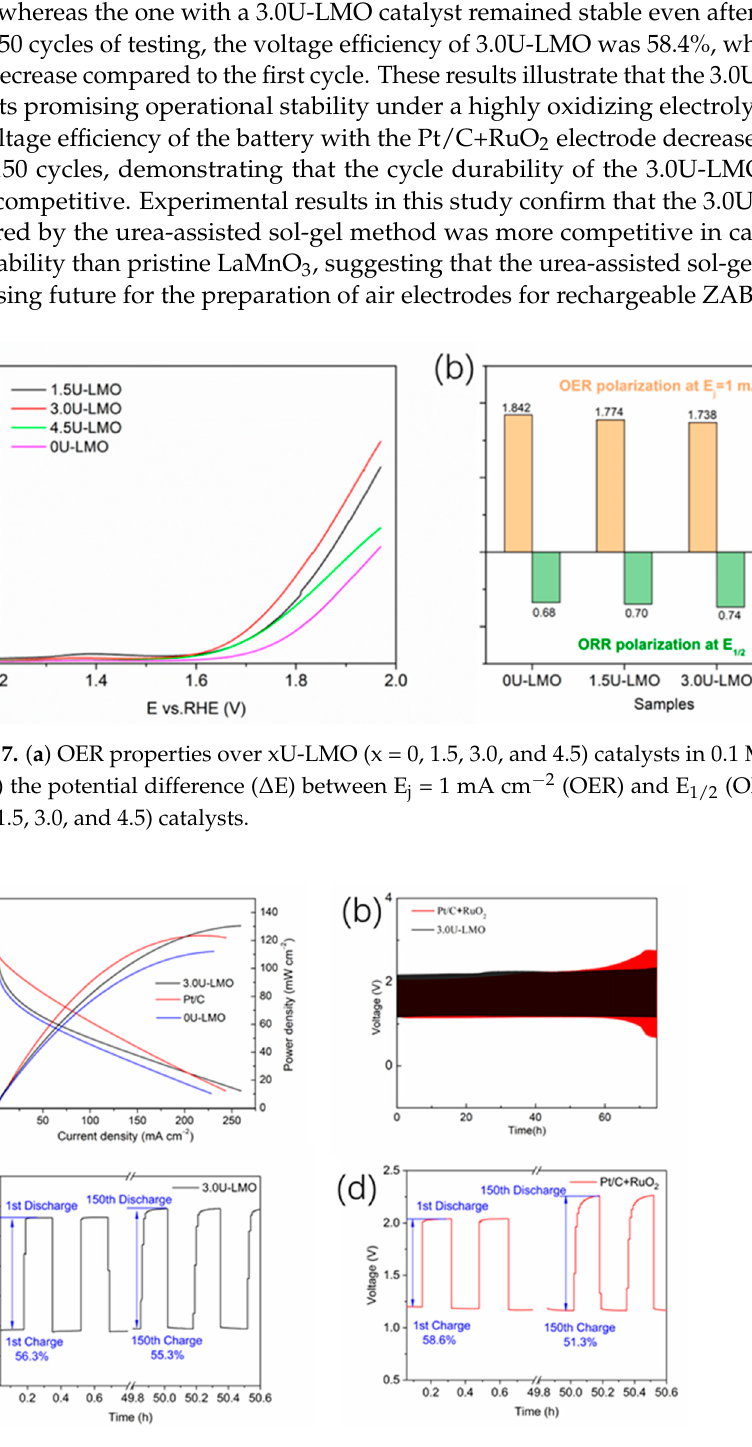
Figure 8. ( a ) I-V curves of the rechargeable ZABs with 0U-LMO, 3.0U-LMO, and Pt/C catalyst as the air electrode, respectively; ( b ) comparison of discharge–charge cycling features for 3.0U-LMO perovskite and Pt/C+RuO 2 at 10mA cm − 2 ; the operation stability of ZABs with ( c ) 3.0U-LMO perovskite and ( d ) Pt/C+RuO 2